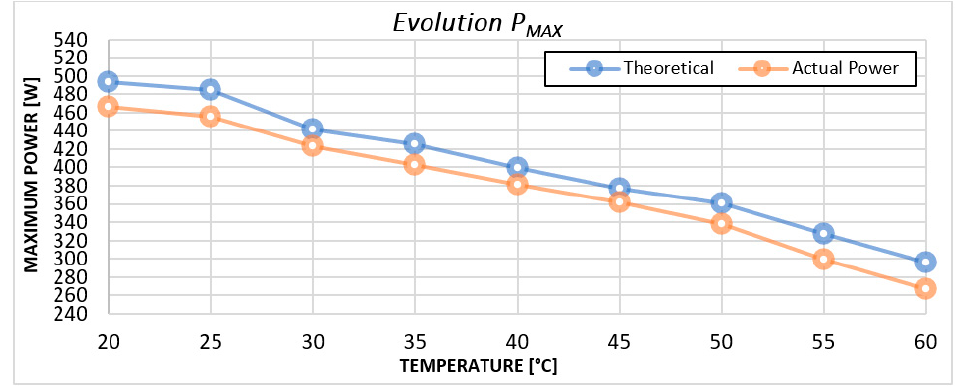
Figure 7. Plot representation of the temperature influence to the P MAX characteristics of the PV generator.